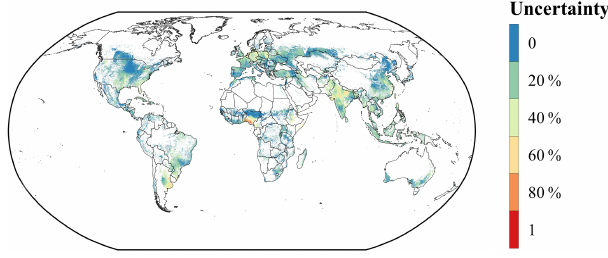
Figure 5. Global uncertainty map of GCI30 during 2016–2018, where regions in red represent higher uncertainty, and those in blue represent lower uncertainty.